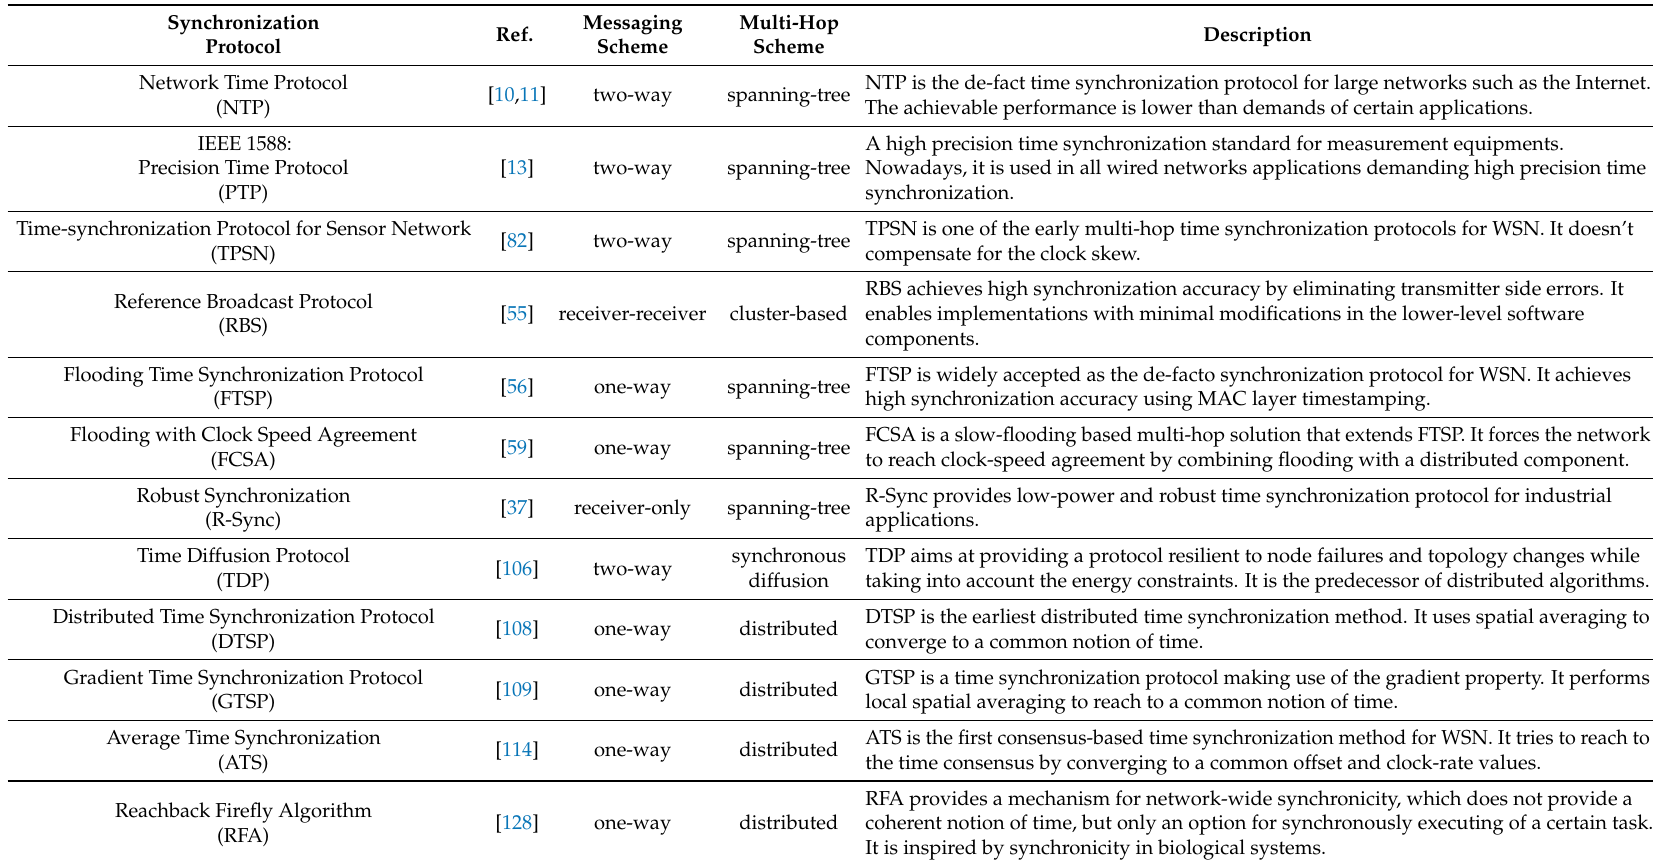
Table 9. A summary of time synchronization